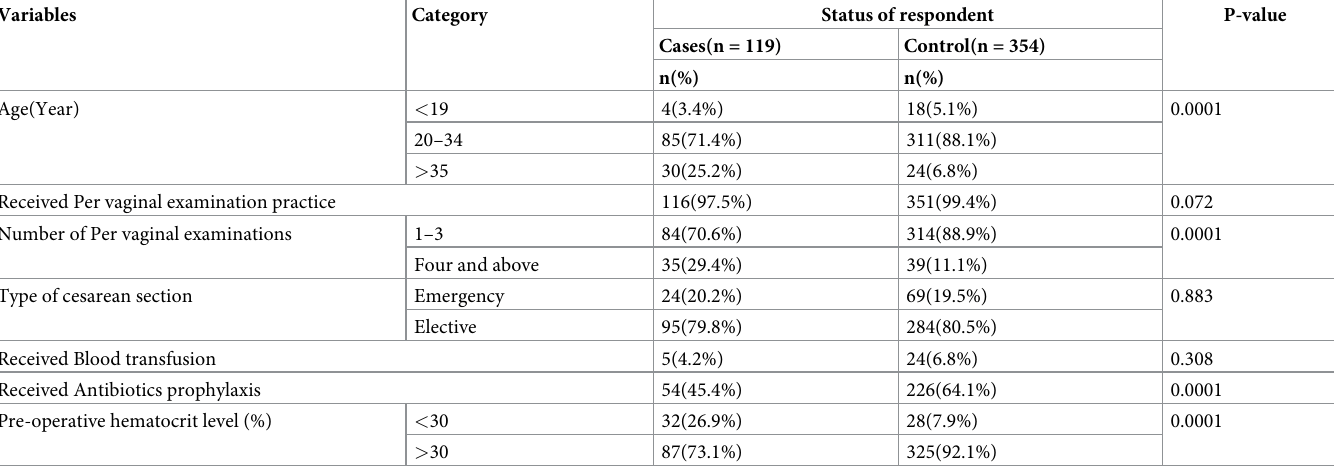
Table 1. Maternal and procedure related factors of mothers with post cesarean section surgical infection at Dire Dawa administration public hospitals, Eastern Ethiopia.